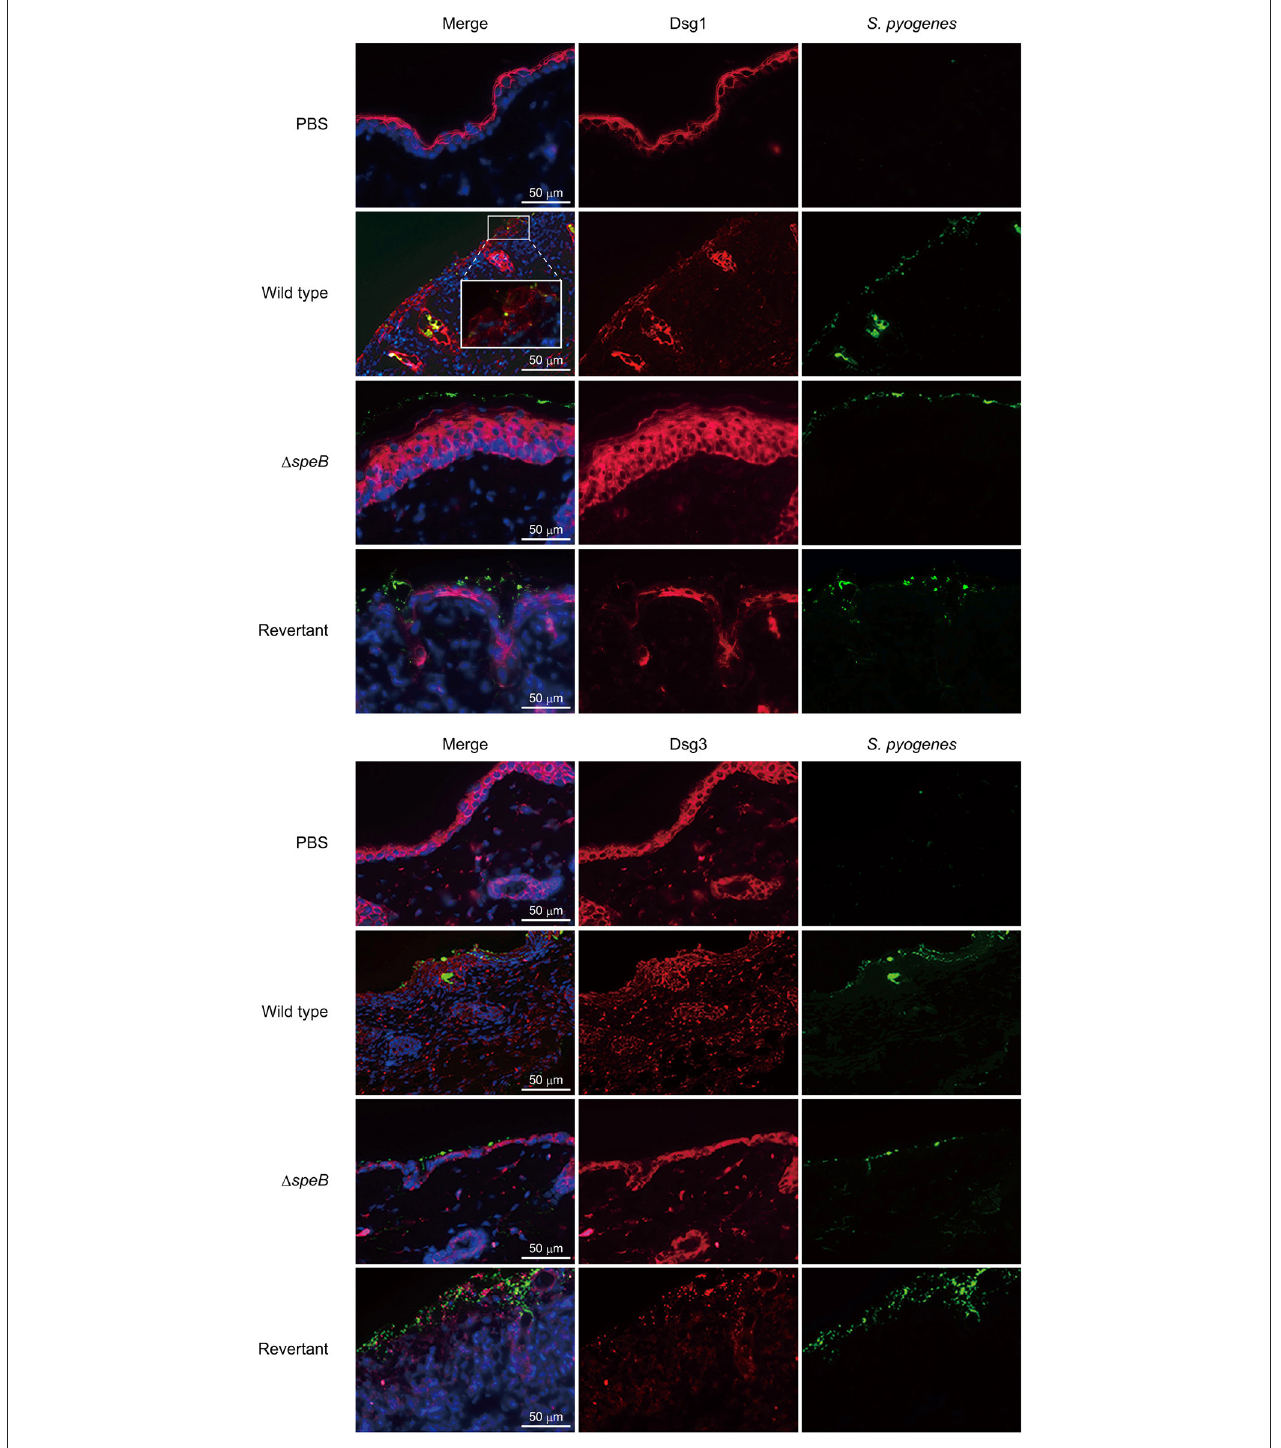
FIGURE 4 | SpeB-mediated cleavage of desmogleins contributes to epidermal barrier dysfunction. Cutaneous sections obtained from mice infected with the examined S. pyogenes strains were subjected to immunofluorescence staining. Dsg1 and Dsg3 were labeled with anti-Dsg1 and anti-Dsg3 antibodies, respectively, followed by incubation with an Alexa Fluor 647-conjugated antibody. S. pyogenes was labeled with anti-Group A carbohydrate and Alexa Fluor 488-conjugated antibodies, and cell nuclei were stained with Hoechst 33342. Obtained tissue sections were analyzed using a confocal laser microscope. The boxed area is magnified in the box panel below. Data shown are representative of at least three separate experiments.